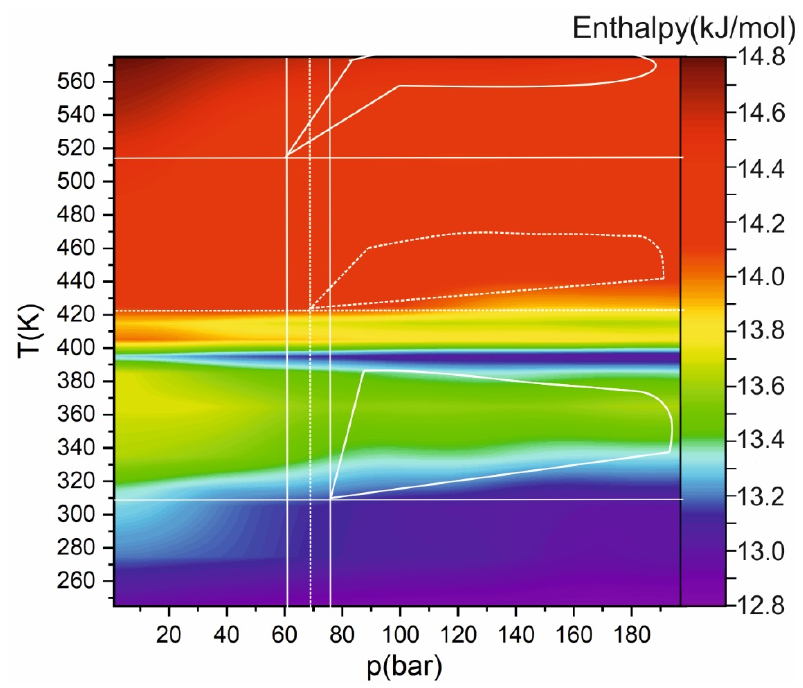
Figure 6. Heat map of enthalpy dependence on pressure and temperature. Solid lines show the critical temperature and pressure of carbon dioxide and ethanol; dashed lines correspond to critical mixture parameters. (Solid lines for carbon dioxide and dashed lines for mixtures.)